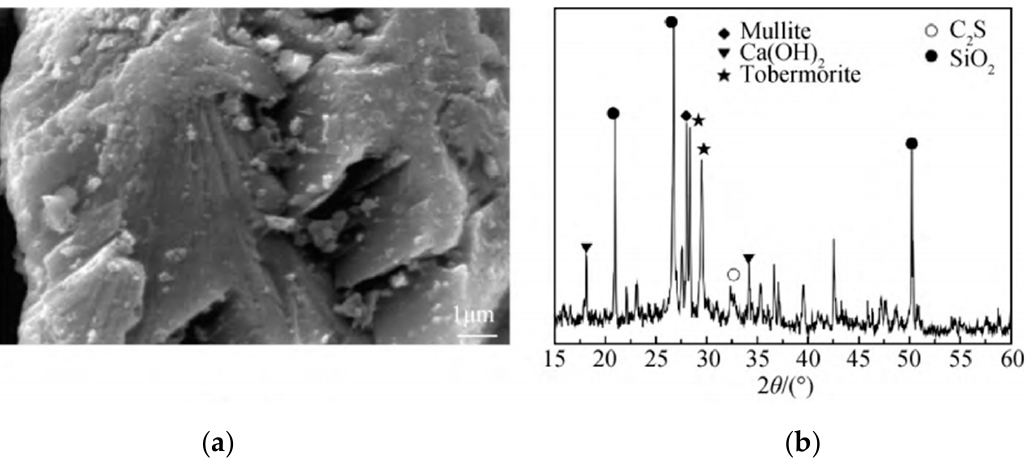
Figure 2. SEM image and XRD pattern of recycled powder. ( a ) SEM image, ( b ) XRD pattern.